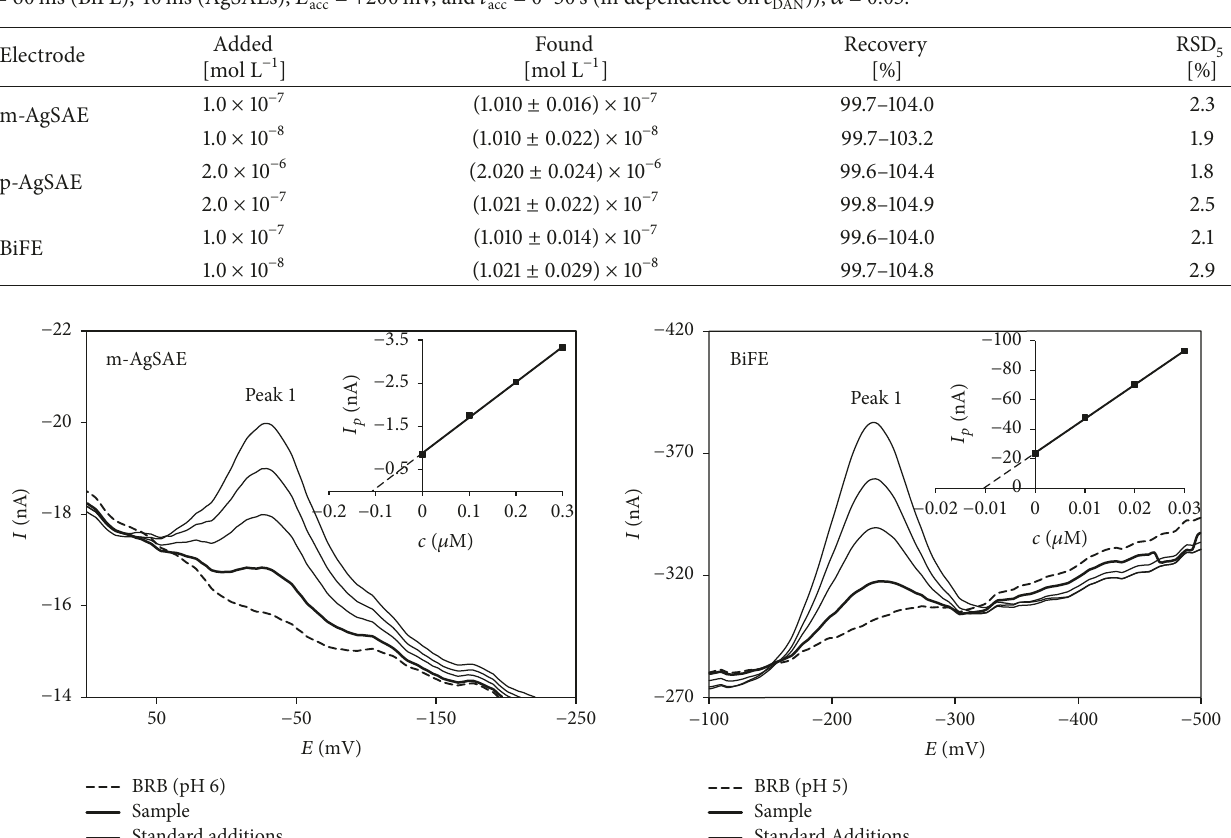
Table 8: Repeatability and recovery of DAN determination in spiked drinking water using p-AgSAE, m-AgSAE, and BiFE (DPAdSV, BRB (pH 5.0 (BiFE), 6.0 (AgSAEs)), 𝐸 in = +200mV, 𝐸 = 60 ms (BiFE), 40ms (AgSAEs), 𝐸